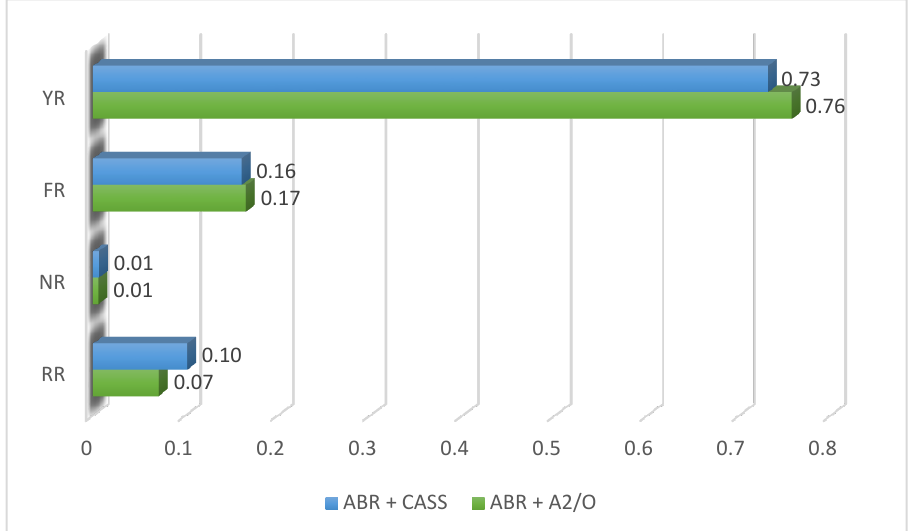
Figure 4. Comparative analysis of 2 process emergy flows. RR: ratio of renewable resource energy flow to total energy flow, RR = R/(R + N + F + Y); NR: ratio of non-renewable resource energy flow to total energy flow, NR = N/(R + N + F + Y); FR: ratio of purchased energy flow to total energy flow, FR = F/(R + N + F + Y); YR: ratio of yield energy flow to total energy flow, YR = Y/(R + N + F + Y).